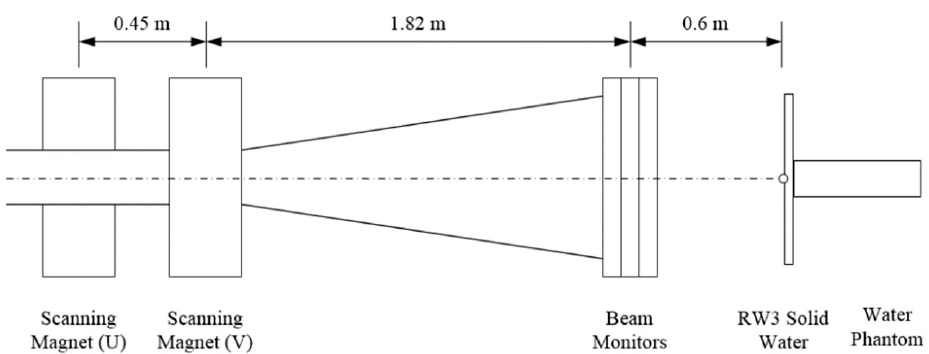
Figure 1. Simplified SAPT nozzle modeling